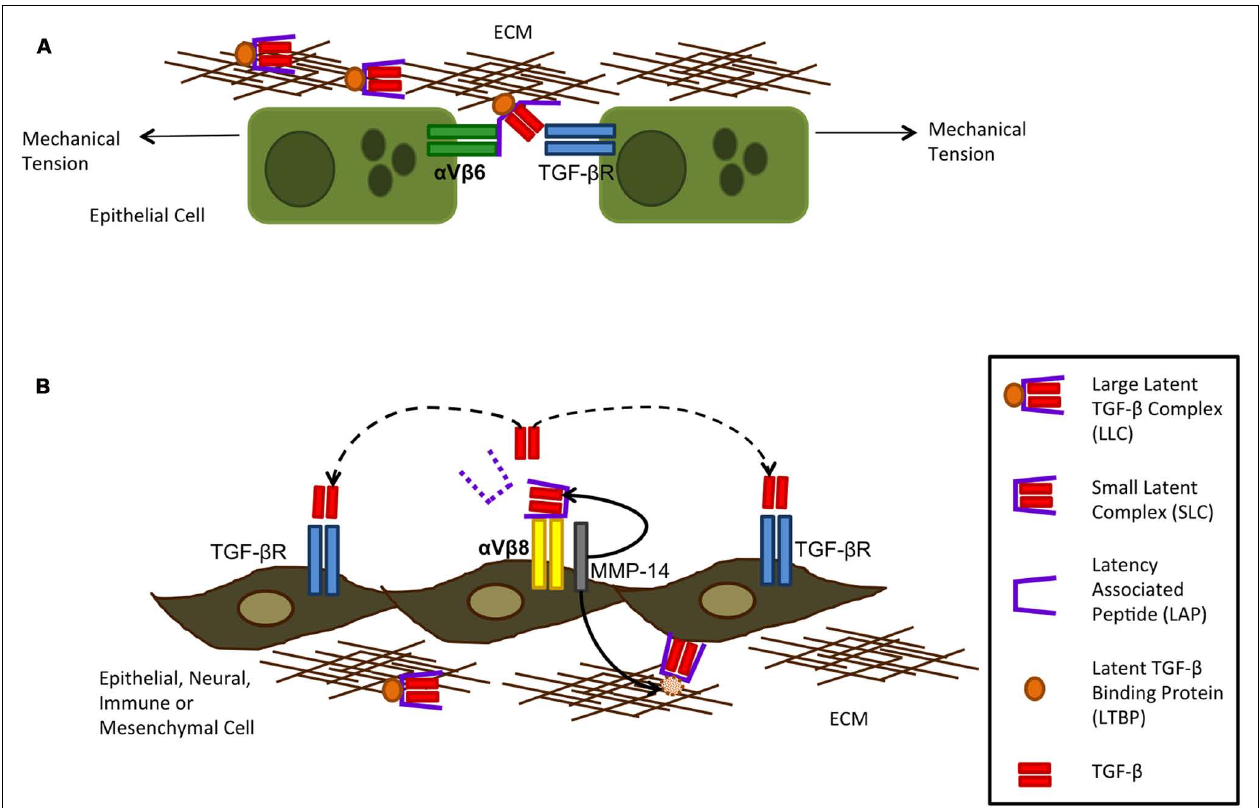
FIGURE 3 | Integrin activation ofTGF- β can occur via α V β 6 (A) and α V β 8 (B). Integrin α V β 6 is restricted to the epithelium and can activateTGF - β following mechanical tension of the cells alongside binding of the large latent complex (LLC) to α V β 6 and extracellular matrix (ECM) proteins.This tension exposes the activeTGF - β through opening of the latency-associated peptide (LAP) allowing it to bind to its receptor on neighboring epithelial cells only as